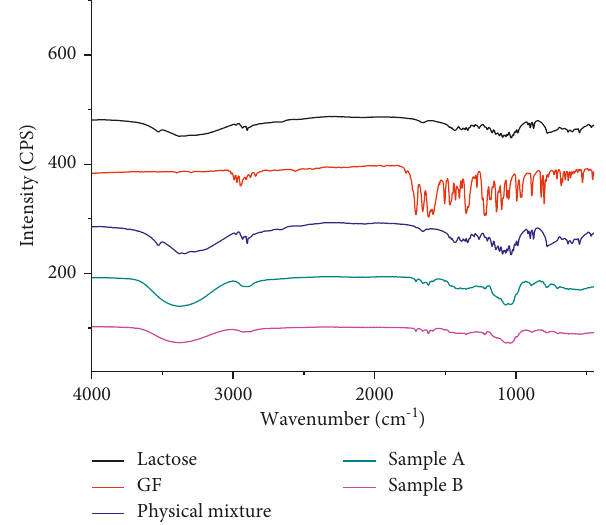
Figure 2: FTIR spectra of the raw materials, physical mixture, and